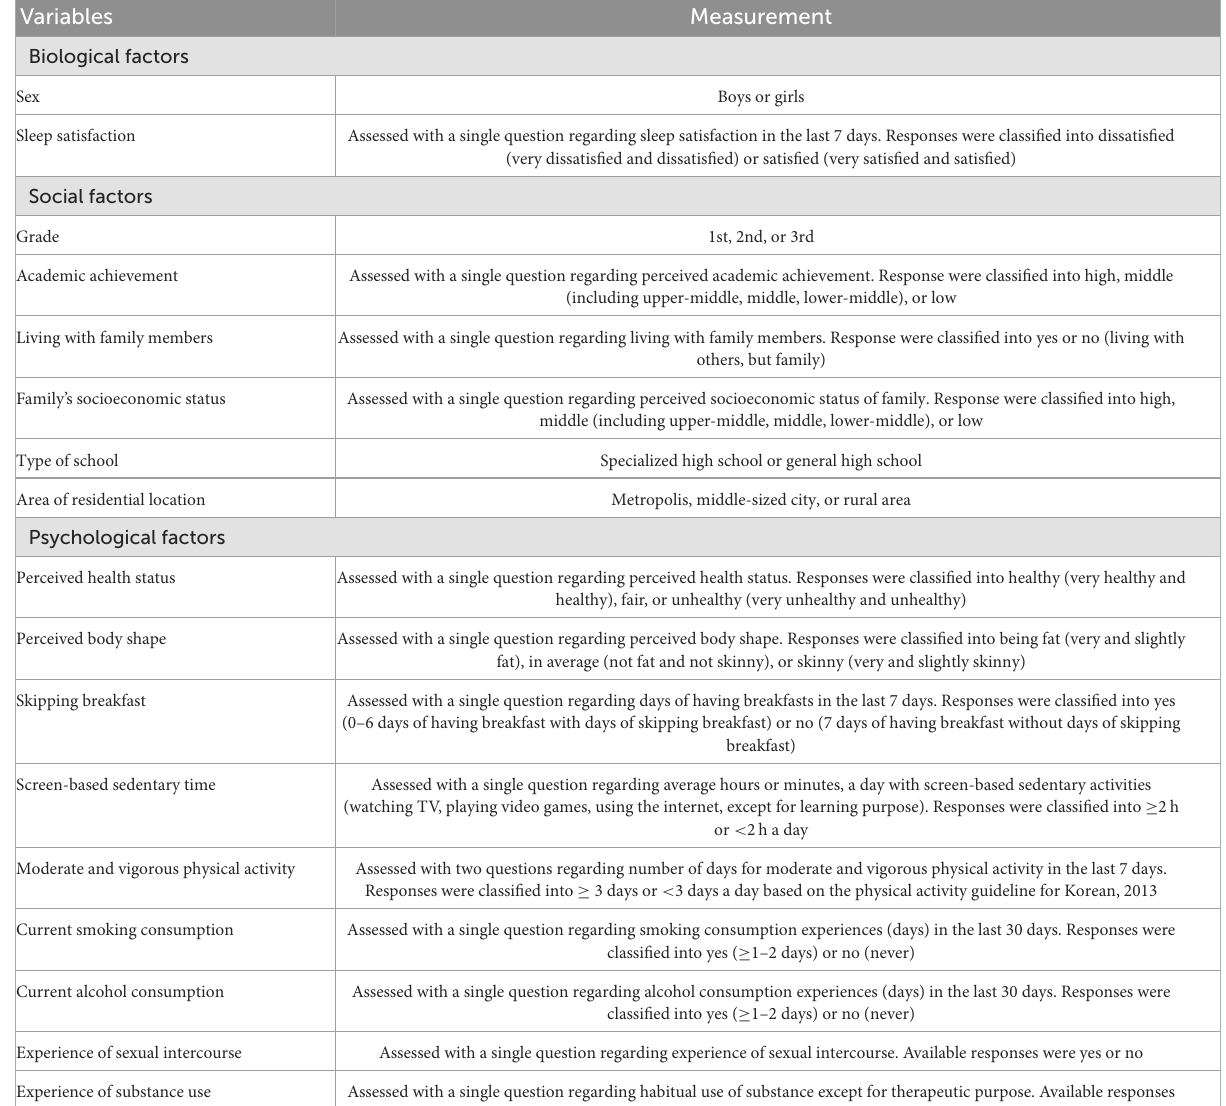
TABLE 1 Measurement of